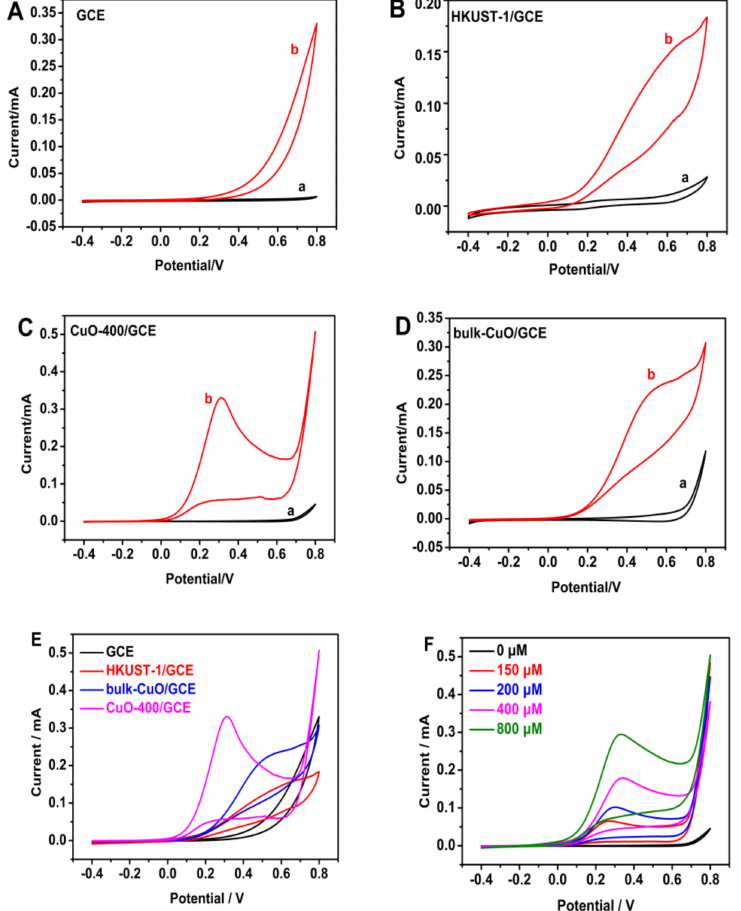
Figure 6. CV curves for di ff erent electrodes ( A – E ) and di ff erent concentrations of hydrazine hydrate at CuO-400 / GCE ( F